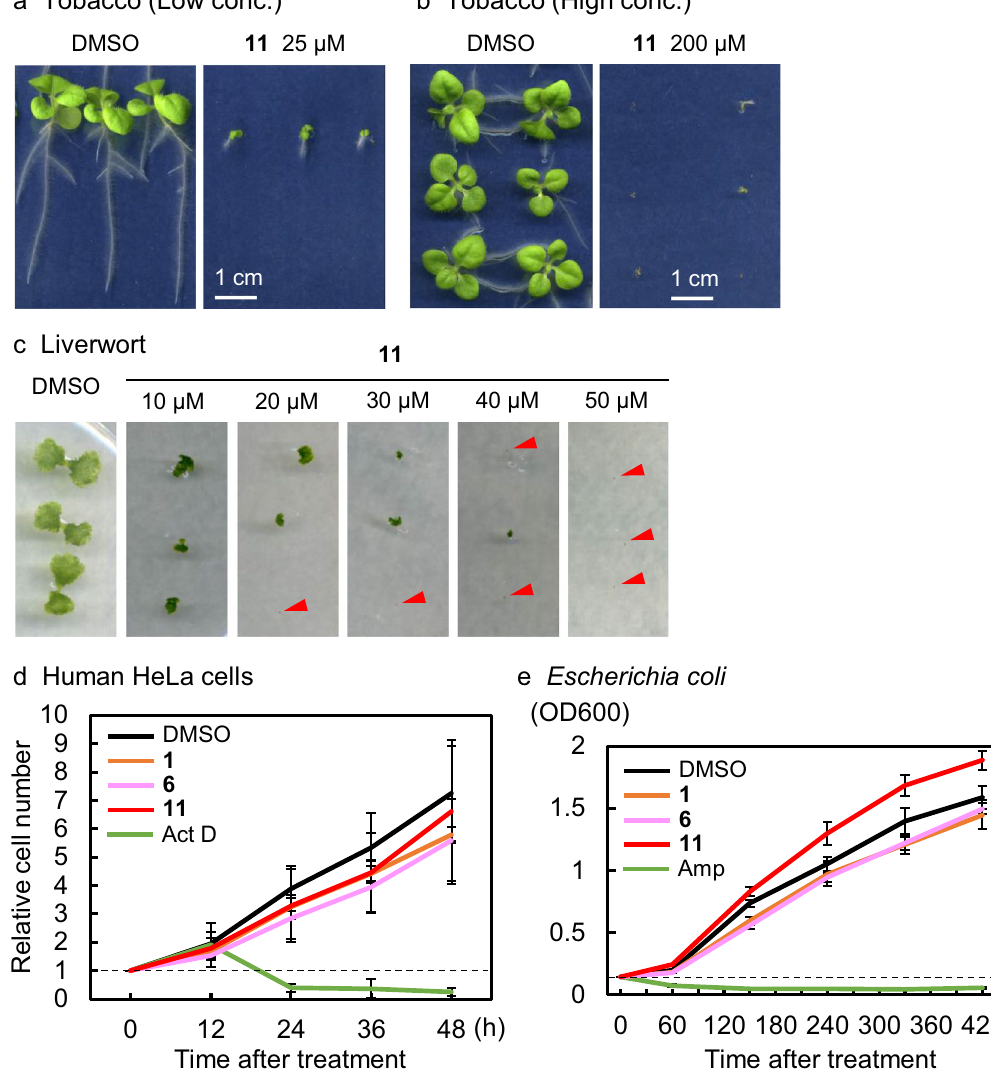
Figure 5. Inhibitory effects on growth of the KAND 11 in non- Arabidopsis organisms. ( a ) Two-week-old, wild- type Nicotiana tabacum SR-1 seedlings were grown on vertically placed MS plates with 25 μM of KAND 11 . ( b ) Two-week-old, wild-type N. tabacum SR-1 seedlings were grown on horizontally placed MS plates with 200 μM of KAND 11 . ( c ) Two-week-old, wild-type Marchantia polymorpha Tak-1 gemmae were grown on Gamborg B5 plates with the indicated concentrations of KAND 11 . Red arrows indicate gemmae that ceased growing for the duration of the 2-week incubation. ( d ) Cell proliferation assay of HeLa cells. The numbers of viable cells were measured using a Cell counting kit-8 (Dojindo) at fixed time intervals. As a control, HeLa cells were treated with 5 μg/ml of actinomycin D (Act D), which inhibits transcription by RNA polymerases and causes cell death. The assays were conducted in triplicate. ( e ) Cell proliferation assay of Escherichia coli bacteria. Growth of E. coli was analyzed by measuring OD600. As a control, cells were treated with 50 μg/ml of ampicillin (Amp), which inhibits bacterial cell wall synthesis. The assays were conducted in